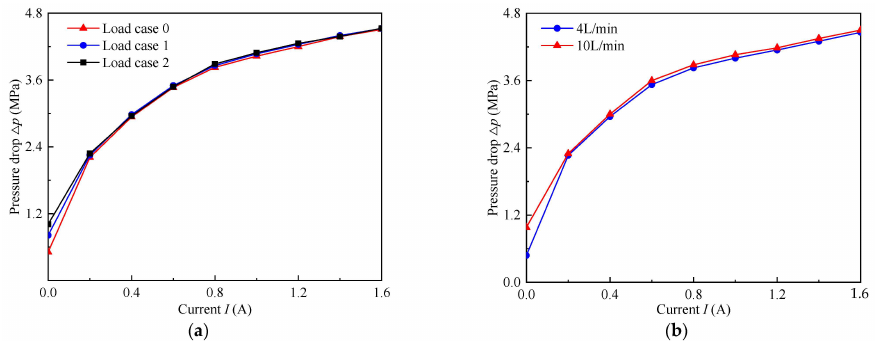
Figure 17. Pressure drop change of the optimal MR valve under different excitations: ( a ) load cases, ( b ) flow rates. The experimental pressure drops were compared for 0.4 A to 1.6 A current in steps of 0.4 A, and the results are presented in Figure 18. It can be clearly noted that the pressure drop of the initial and optimal MR valve has exactly alike variation tendency with the excitation current, and the optimal pressure drop is greater than that of the initial. As observed, based on load case 0 and a flow rate of 4 L/min, the pressure drop of the initial MR valve gradually enhanced from 2.65 MPa at 0.4 A current to 4.03 MPa at 1.6 A current, and simultaneously the pressure drop of the optimal MR valve also went up gradually in a nonlinear fashion from 2.96 MPa at 0.4 A current to 4.46 MPa at 1.6 A current. In other words, the increment amplitude in the pressure drop of the optimal MR valve is 11.7% at 0.4 A current and 10.67% at 1.6 A current, respectively, compared with the initial MR valve.